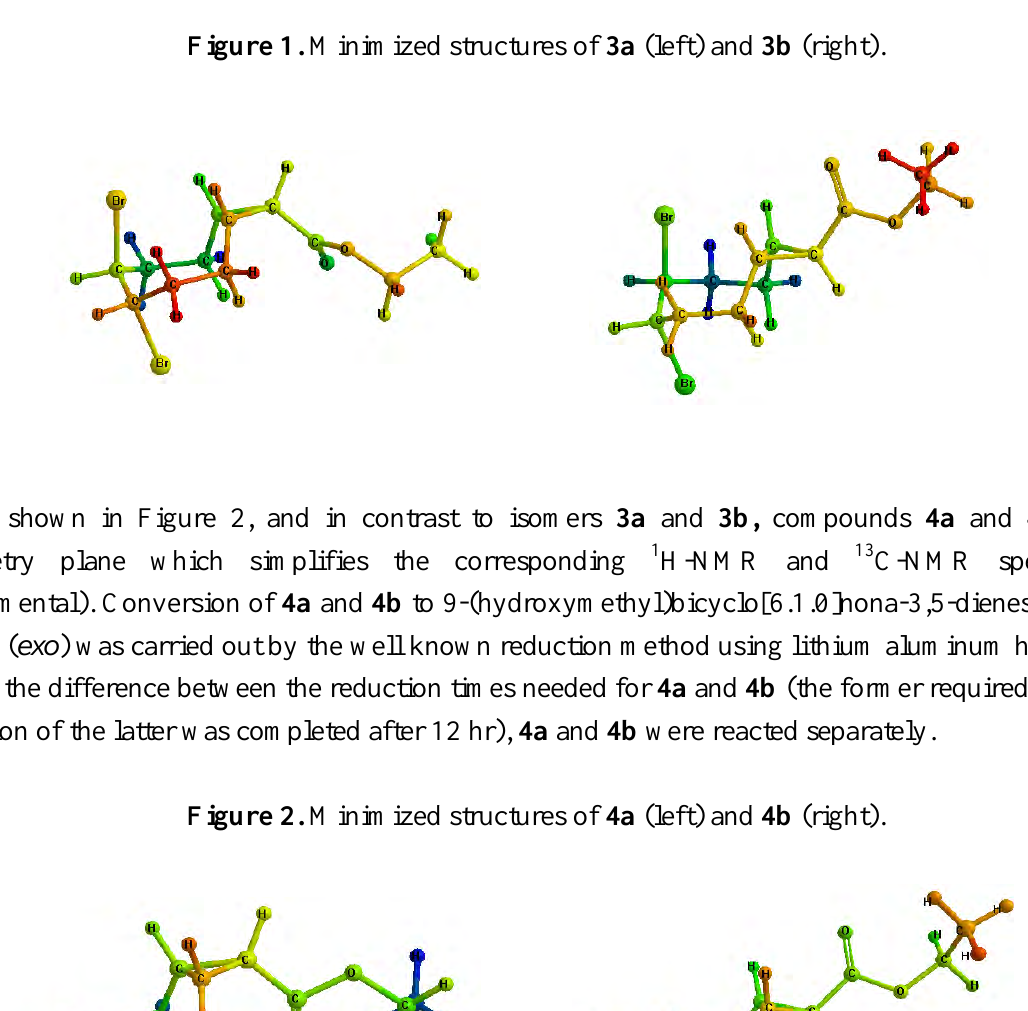
Figure 1. Minimized structures of 3a (left) and 3b (right).